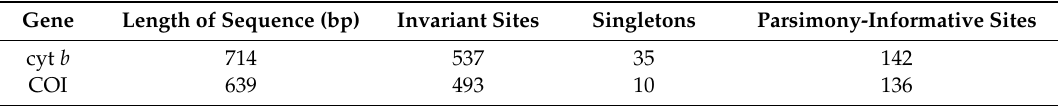
Table 1. Number of parsimony-informative sites, singletons, and invariant sites (in base pairs) for each gene region among the ingroup